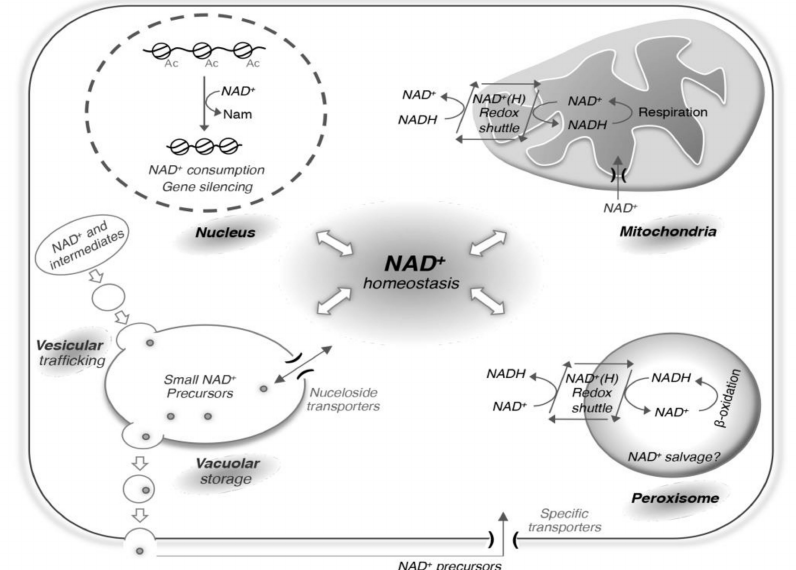
Figure 2. Cellular processes that are closely connected with NAD + homeostasis. Various cellular processes together with compartmentalization of intracellular NAD + and its derivatives contribute to the regulation of NAD + homeostasis. For example, NAD + and intermediates can enter the vacuole through vesicular tracking and are then converted to small NAD + precursors. Small NAD + precursors such as NR can travel between the vacuole and cytoplasm through specific nucleoside transporters. Small NAD + precursors can exit cells likely by vesicular tra ffi cking and re-enter through specific transporters on the plasma membrane. Sirtuin mediated gene silencing in the nucleus consumes NAD + . The nucleus and cytoplasm share the same NAD + pool because NAD + is anticipated to pass the nuclear pore by simple di ff usion. The mitochondrial and peroxisomal NAD + (H) redox shuttle systems do not directly a ff ect NAD + metabolism, instead, they function to balance redox equivalents between the organellar and the cytosolic pools to regulate the NAD + / NADH